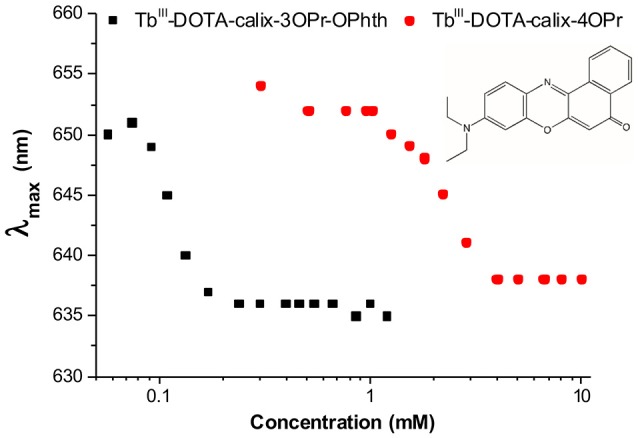
Wavelength of the fluorescence emission maximum (λmax) vs. TbIII concentration in solutions of TbIII-complexes 12a (black) and 12b (red) in the presence of Nile red (λEx = 550 nm).